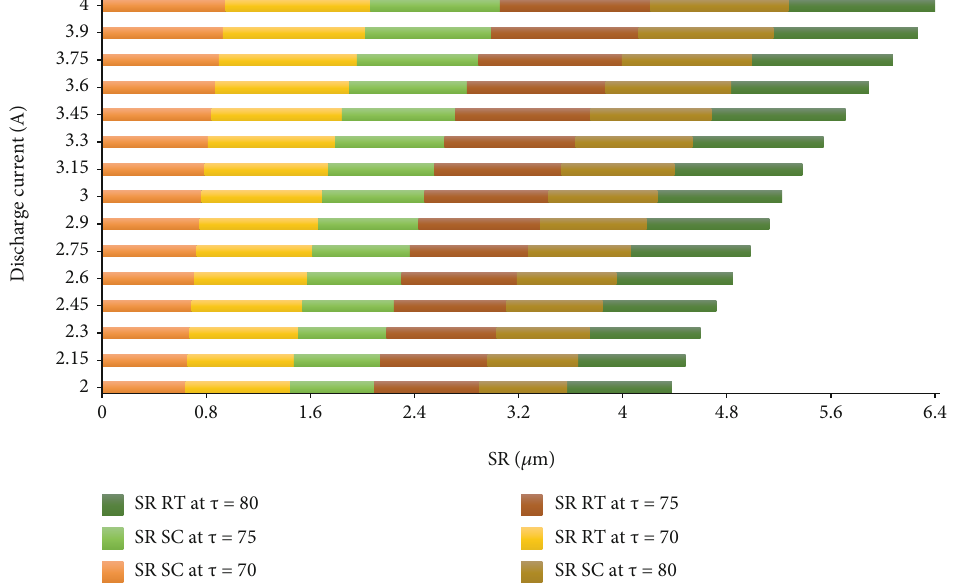
Figure 7: SR vs. discharge current for two types of electrodes at T